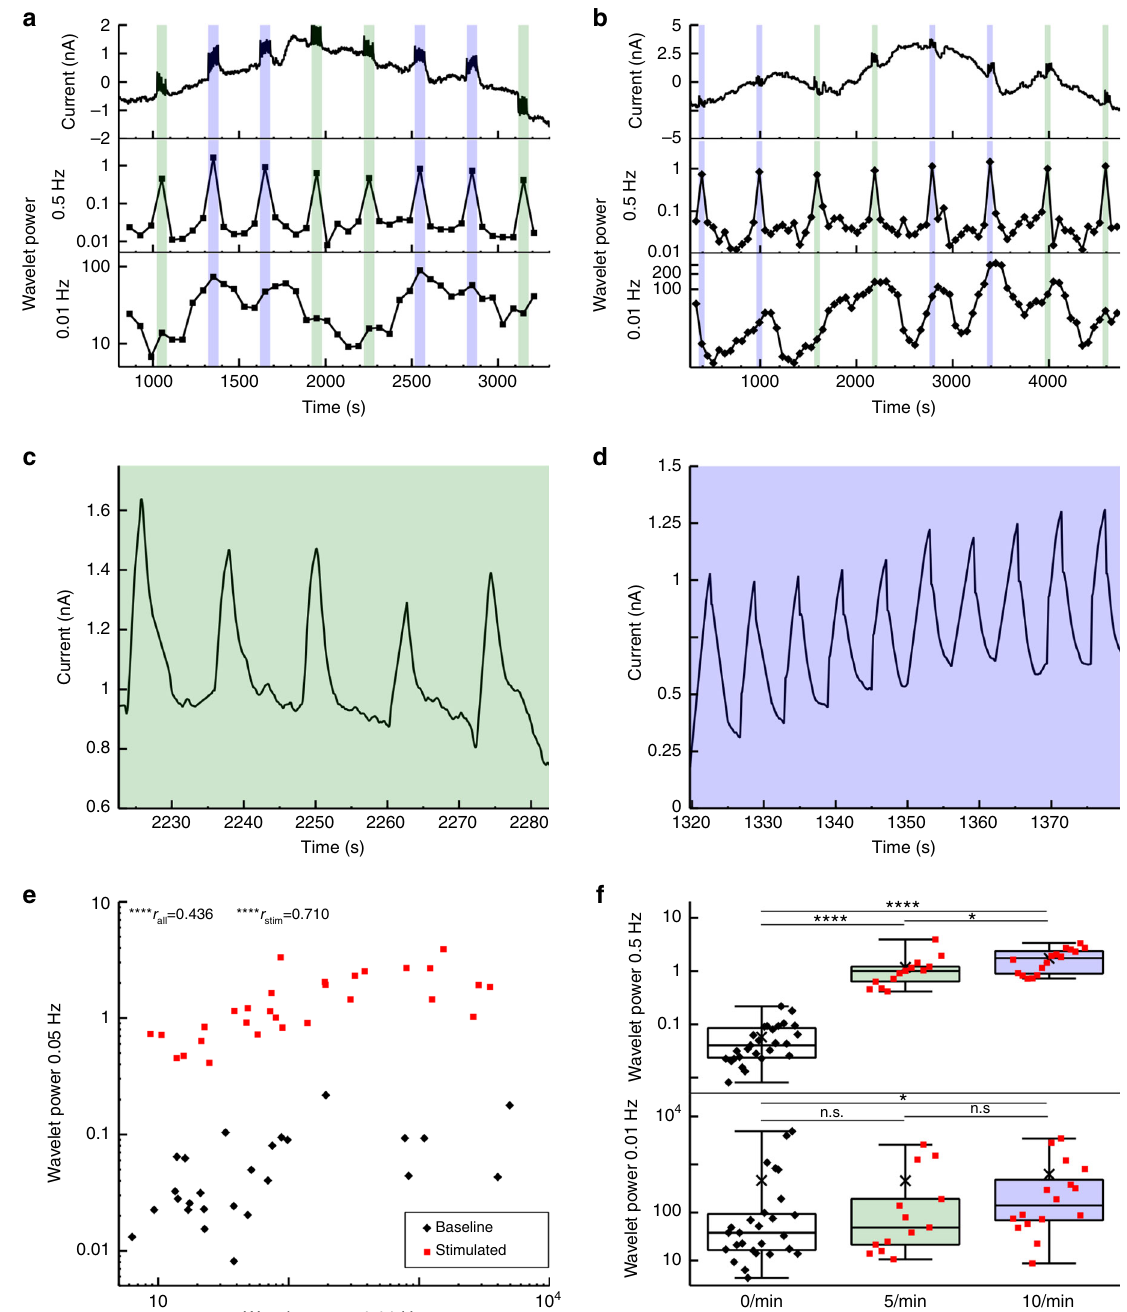
Fig. 6 FSCV recordings of DA transients induced by electrical stimulation. ( a , b , top trace) Continuous FSCV recordings from the ventral striatum of two mice. Five (green interval, c ) or ten transients per minute (blue interval, d ) were induced by electrical stimulation of the VTA. ( a and b , mid and bottom trace) resulting wavelet power at 0.5 Hz and 0.01 Hz. e Correlation of wavelet power at 0.5 Hz and 0.01 Hz in stimulated one-minute intervals (red squares) and non-stimulated one-minute intervals taken from the center of non-stimulated time intervals (black diamonds, n = 4 mice). f Wavelet power in one-minute intervals as a function of the number of induced transients (median ± SEM, x = mean, whiskers indicate minimal and maximal values, n = 4 mice). Welch two-sample t -test: **** = p < 0.001, *** = p < 0.005, ** = p < 0.01, * = p < 0.05